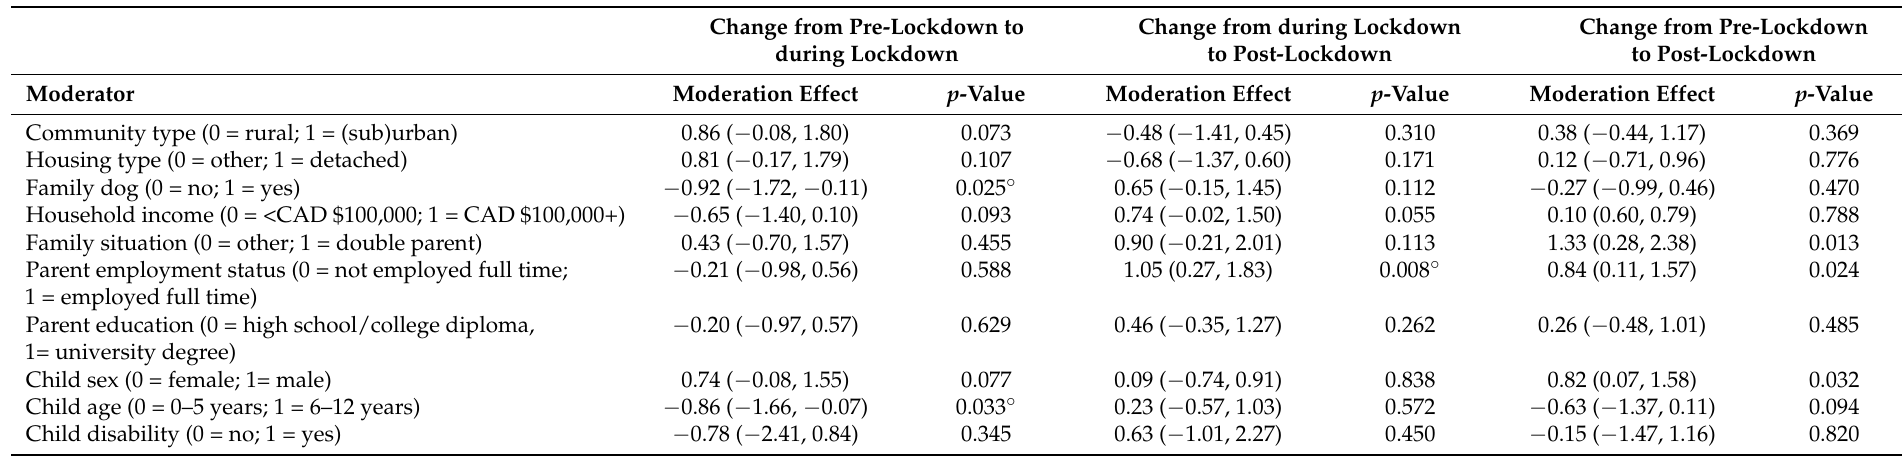
Table 2. Influence of Sociodemographic Moderators on Changes in Parent-Reported Child Physical Activity Over Time During the COVID-19